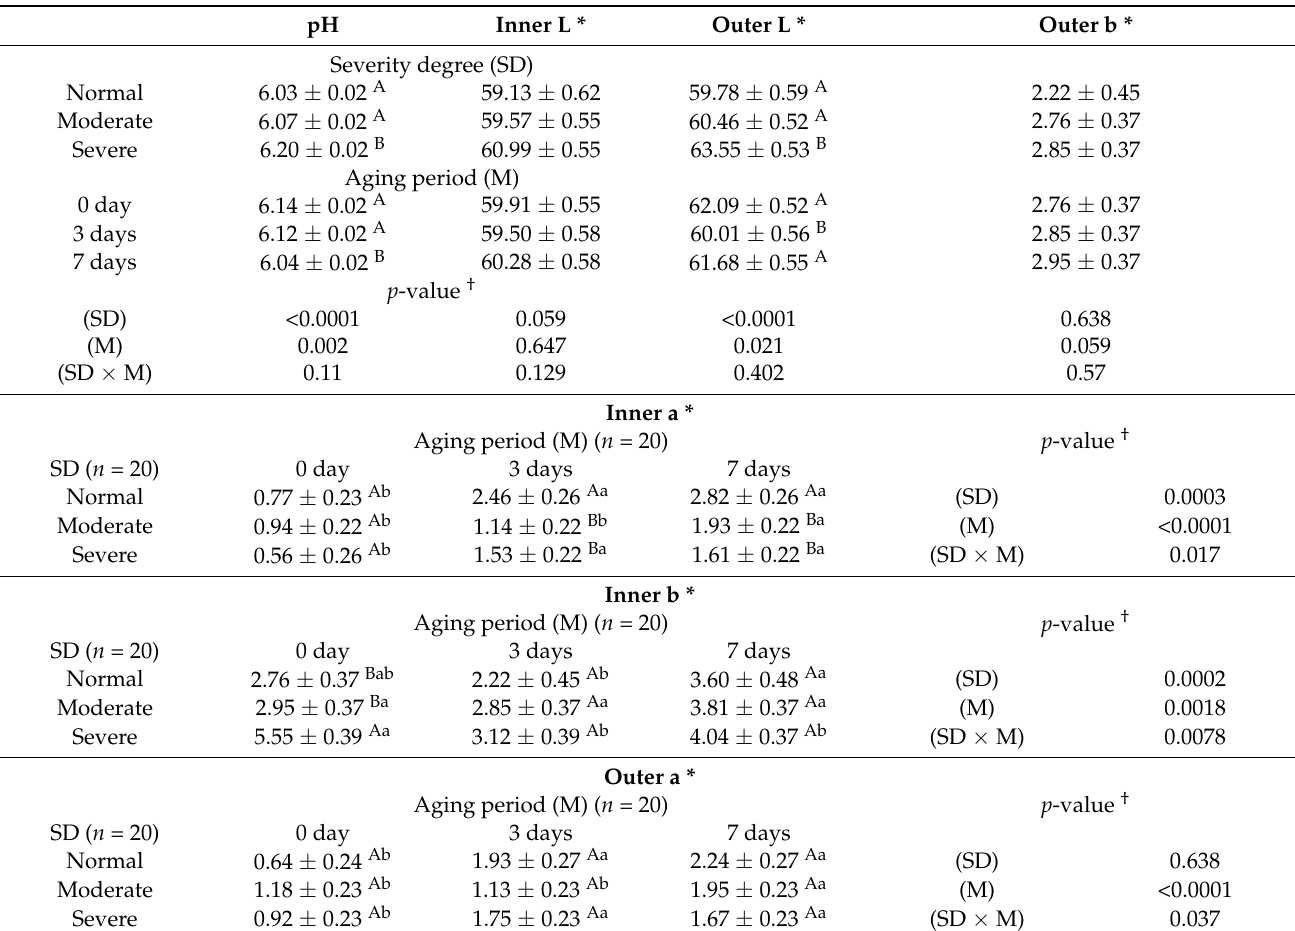
Table 1. Mean values for pH, lightness (L *), red (a *), and yellow (b *) intensities of breast meat from broilers affected by wooden breast myopathy and aged for up to 7